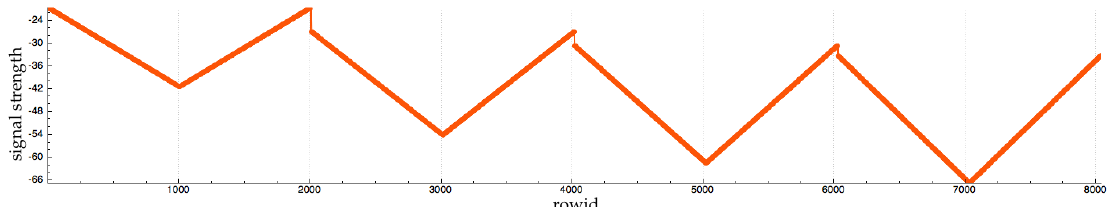
Figure 3. Evolution of RFID signal strength. In rows [0, 2000], the tag is approximately 1 m away from the antenna. In rows [2000–4000], the tag is approximately 4 m away from the antenna. In rows [4000–6000], the tag is approximately 10 m away from the antenna. In rows [6000–8000], the tag is approximately 10 m away from the